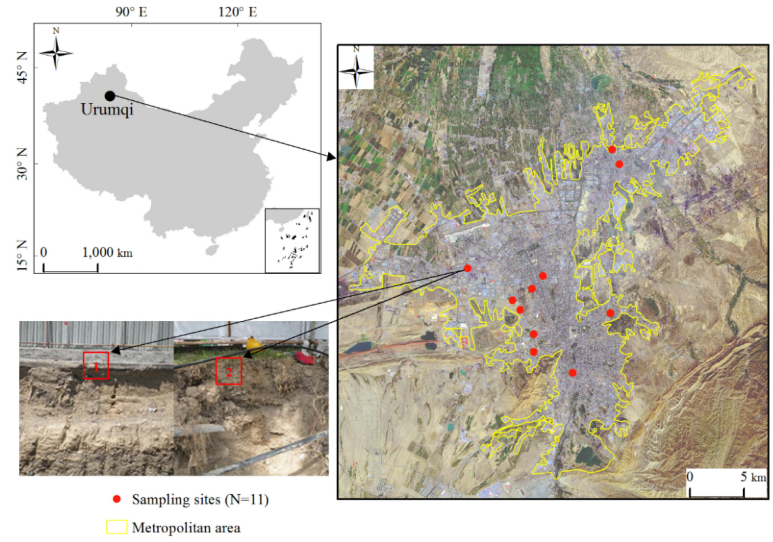
Figure 1. Location of the study area and sampling sites with photos showing the soil profiles of the impervious surface (red box 1) and the adjacent pervious surface (red box 2) in a site. The map on the right is Landsat TM image in true color composite (bands 321(RGB)) in